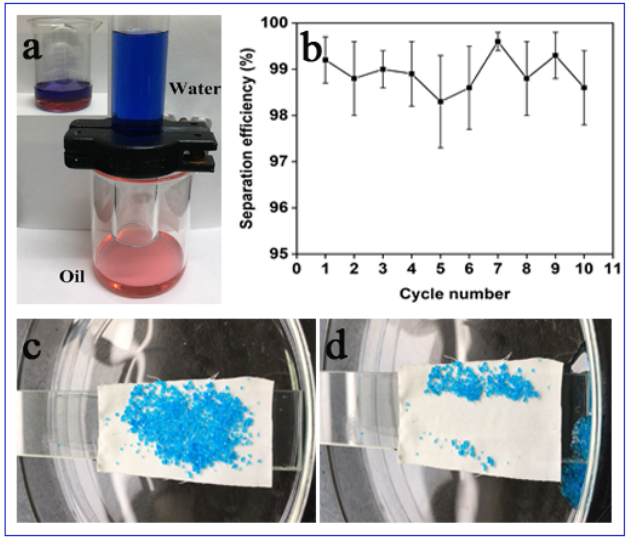
Figure 6. ( a ) Photographs illustrating the oil–water separation; ( b ) cycling separation